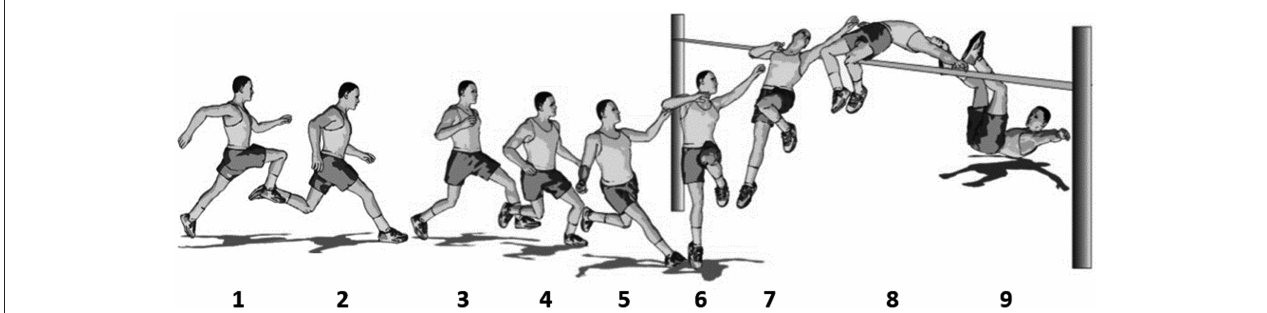
FIGURE 2 | An action sketch of the Fosbury flop (pictures 1–9) illustrating the sub-actions “straight run-up” (1–2), “curved approach” (3–5), “take-off” (5–6), “ascending” (7), “bar clearance” (8), and “landing” (9).